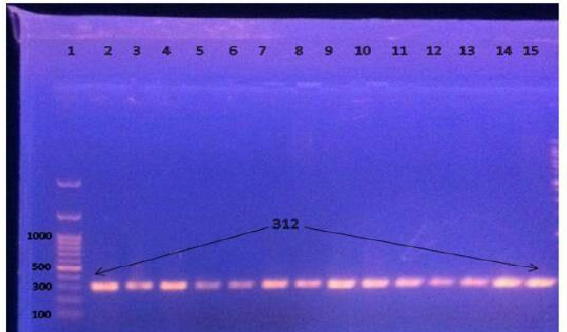
Figure, 4: Agarose gel (1.5 %) electrophoresis of amplified DNA from Theileria annulata. lane M: 1–15, DNA Ladder (1000 bp) some positive product showed clear band in 312